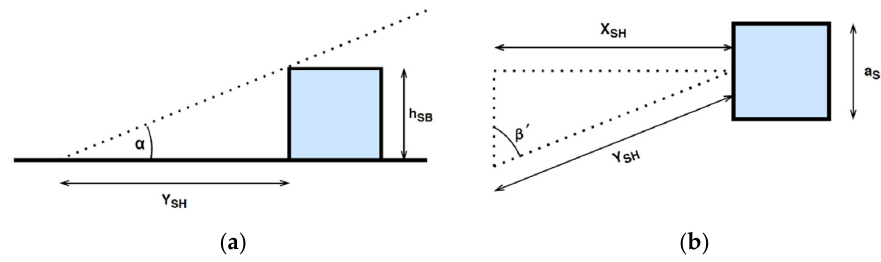
Figure 4. Schema of shading calculations: ( a ) vertical view; ( b ) horizontal view.